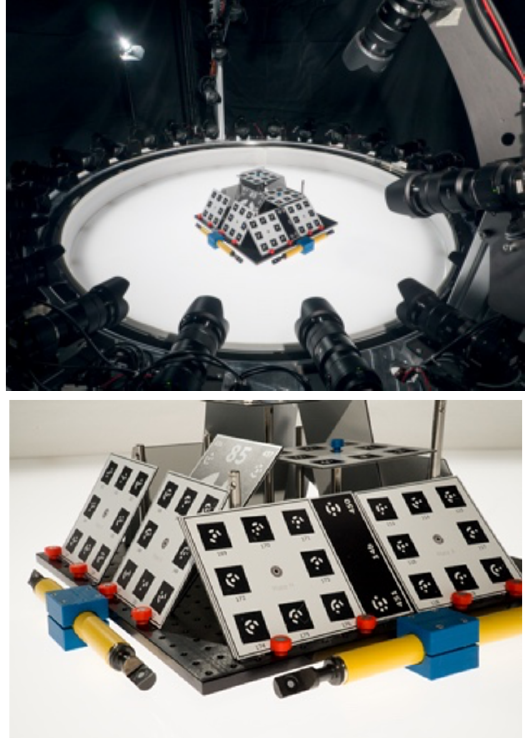
Figure 2: The used testfields for geometric calibration of the camera system (interiors and poses).